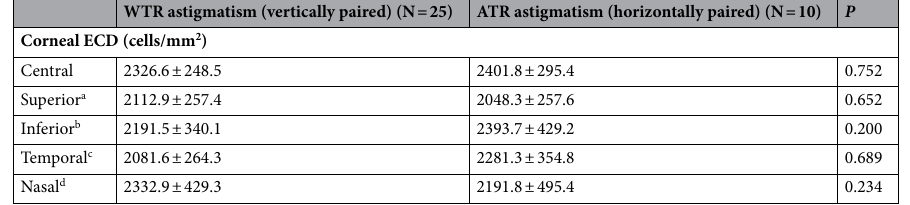
Table 4. Postoperative corneal endothelial cell density of the FSAK group. WTR within-the-rule, ATR against- the-rule, ECD endothelial cell density. a The quadrant in which FSAK was done in the WTR astigmatism group and primary incision was done in the ATR astigmatism group. b The quadrant in which FSAK was done in the WTR astigmatism group and no incision was done in the ATR astigmatism group. c The quadrant in which primary incision was done in the WTR astigmatism group and FSAK was done in the ATR astigmatism group. d The quadrant in which no incision was done in the WTR astigmatism group and FSAK was done in the ATR astigmatism